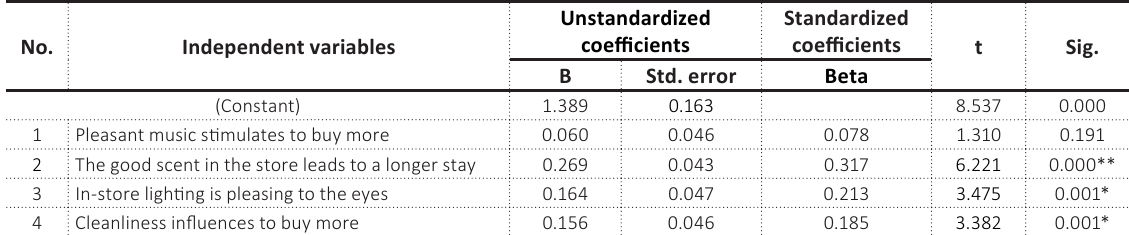
Table 15. Regression analysis of the impact of store ambiance on impulse buying behavior No.